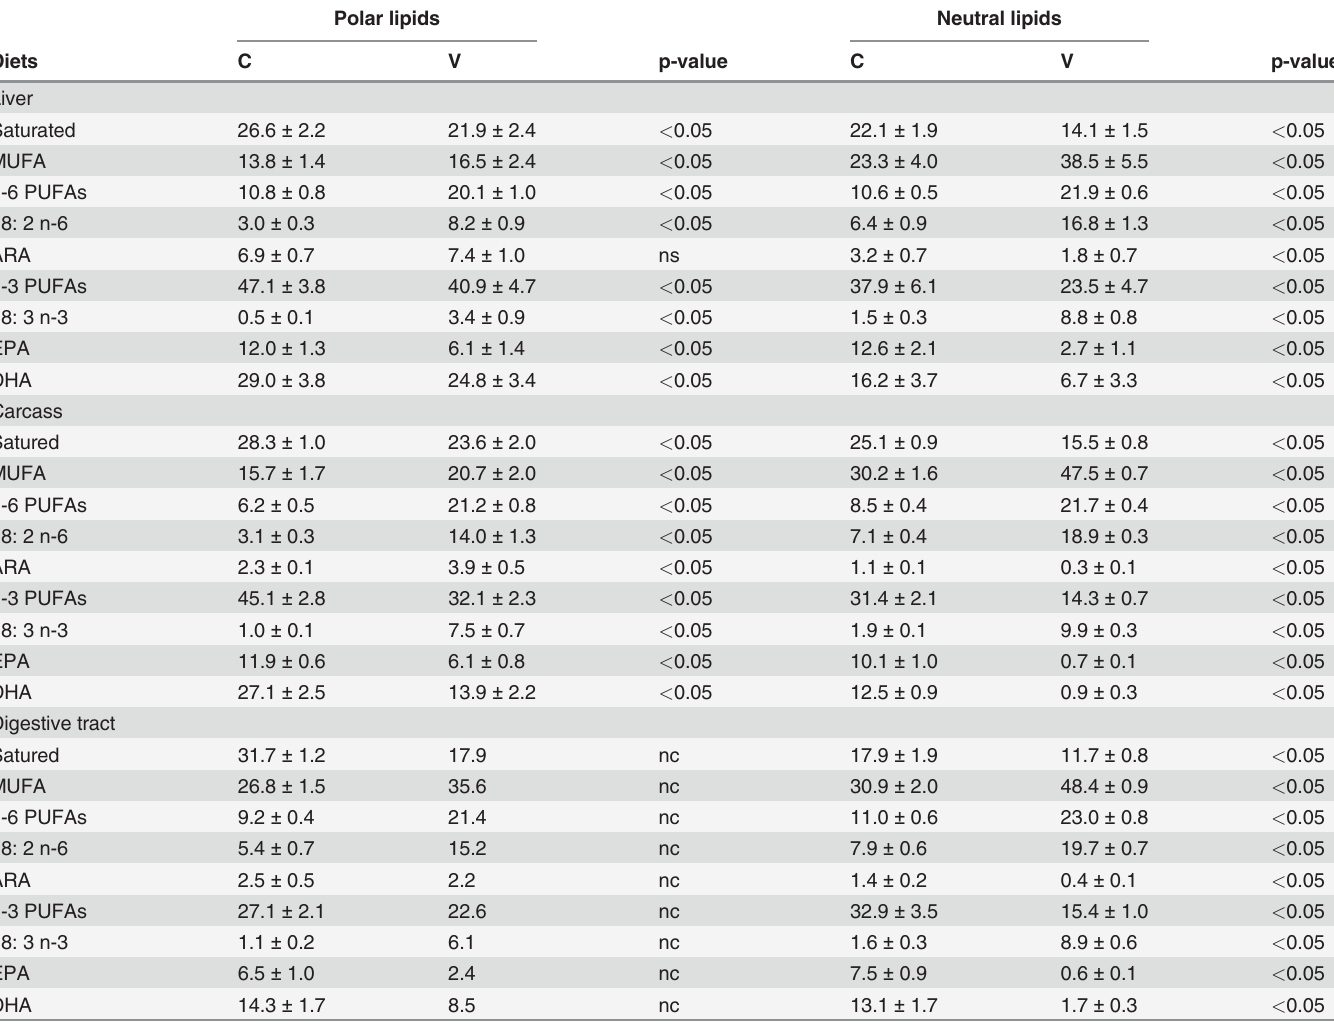
Table 4. Fatty acid composition (% of total FA) of livers, carcasses and digestive tracts (polar and neutral lipid